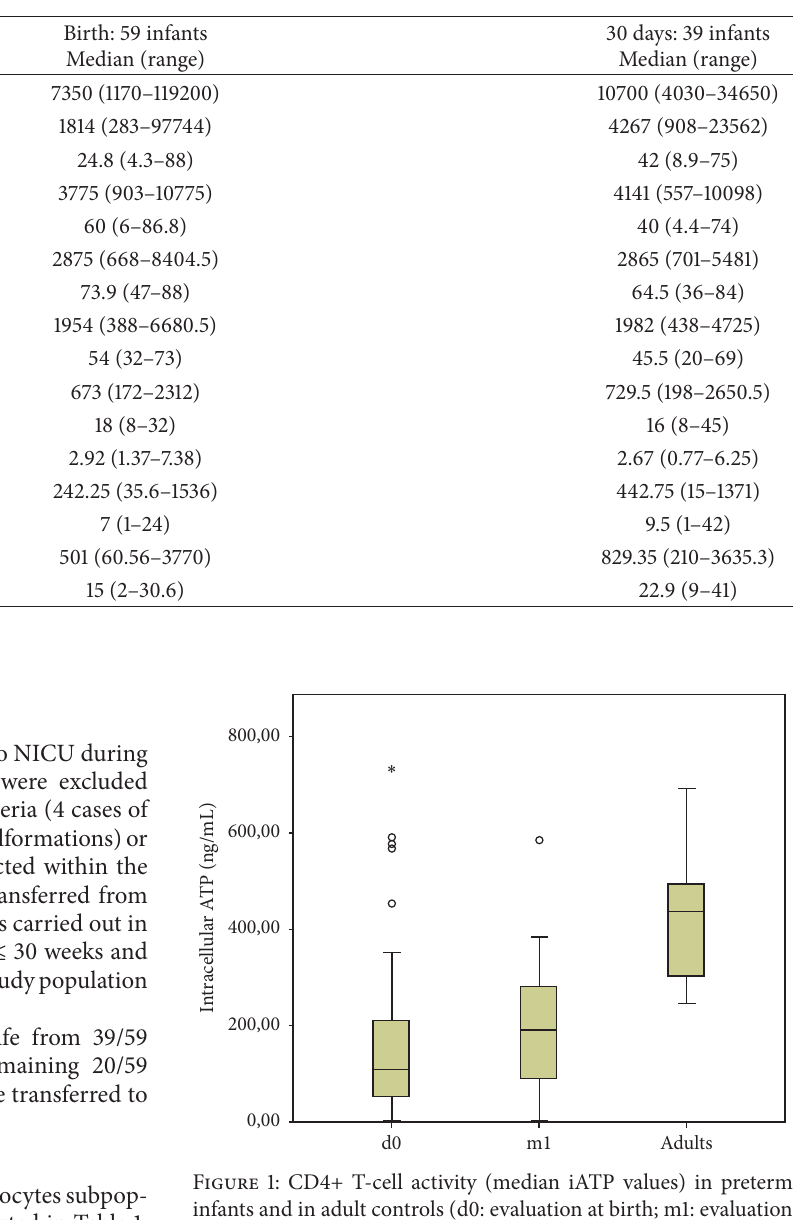
compared to adults controls ( 𝑝 < 0.001 ) as shown in Figure 1. 3.3. Perinatal Factors and CD4+ Activity. Univariate analysis showed no significant correlation between median Immu- Know iATP levels at birth and GA, BW, gender, intrauterine growth retardation (SGA, small for gestational age), and use of prenatal steroids (Table